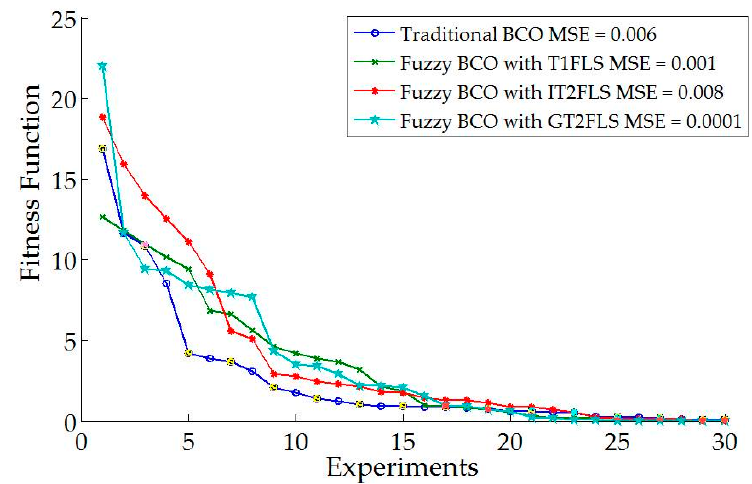
Figure 18. Comparative results of each method with different perturbation in the model.